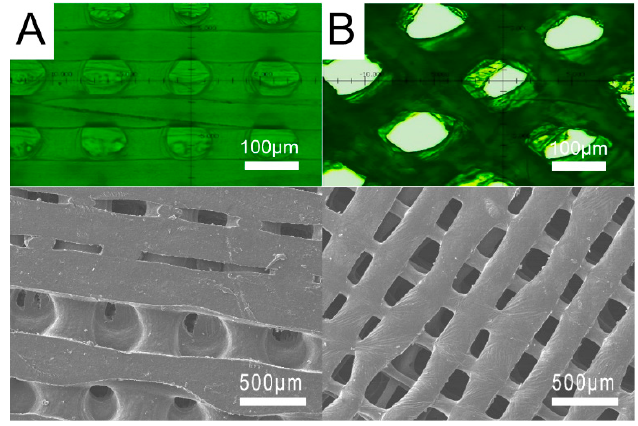
Figure 11. Profile projector and FESEM images of parts manufactured with tip speeds of ( A ) 40 mm/s, ( B ) 70 mm/s.